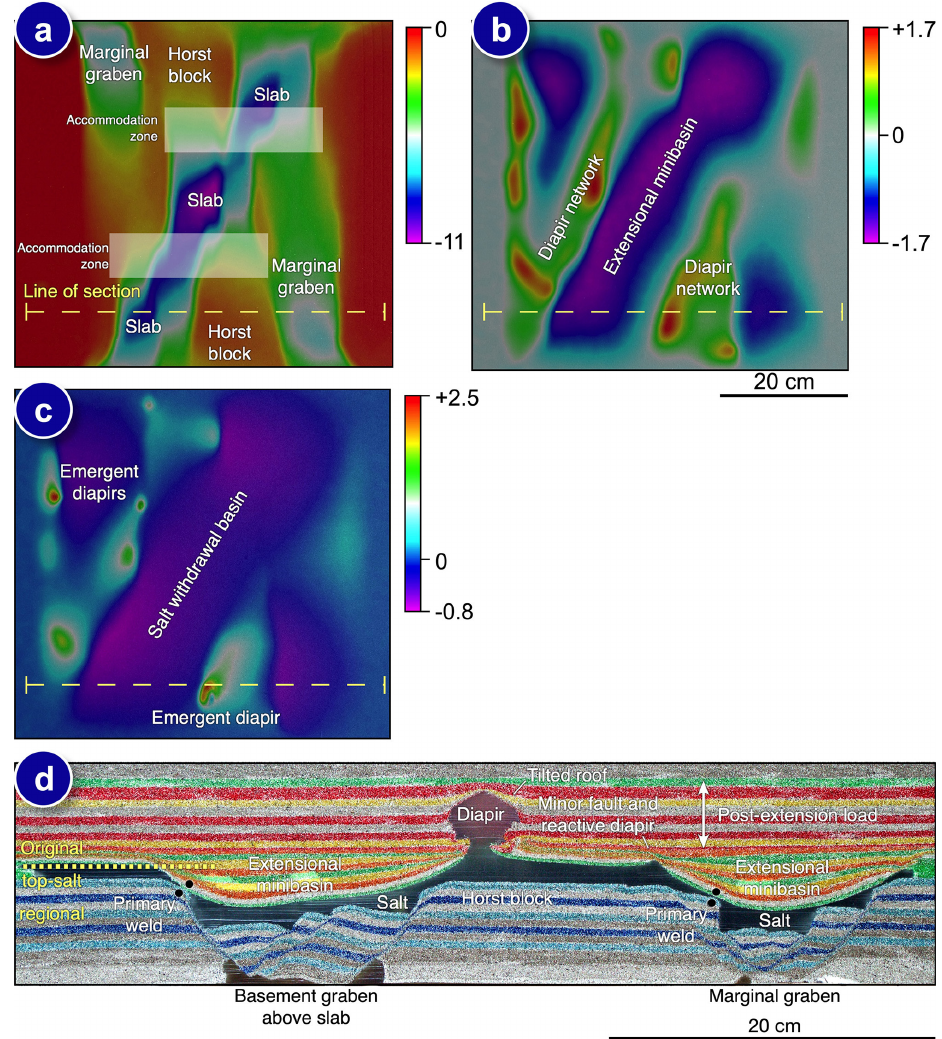
Figure 10. Details from Model 2 (see Table 1). (a) Height-change map that evolved during Stage 1 of Model 2. (b) Height-change map of Model 2 during post-salt extension. (c) Height-change map of Model 2 during post-extension loading. (d) Cross section from Model 2 illustrating extensional minibasins and diapirs of varying heights formed in the footwalls of the subsalt graben. See text for further